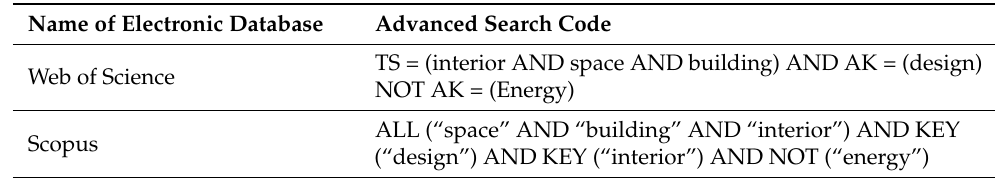
Table 1. Advanced search code electronic database for study with limitation. Name of Electronic